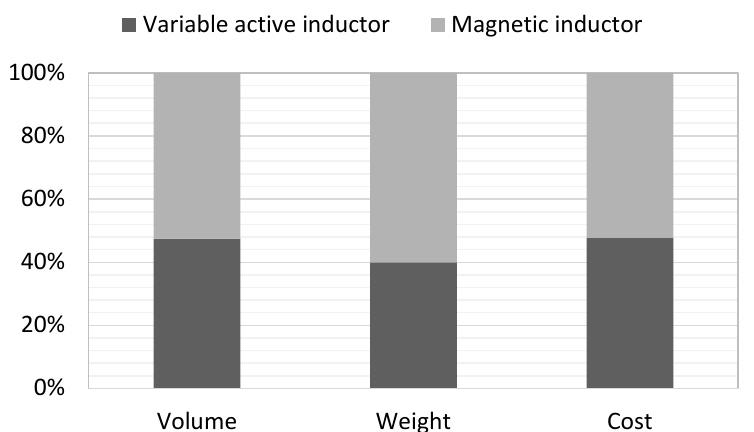
Figure 8. Physical characteristics comparisons between variable active inductor and magnetic in- ductor. Dark grey: variable active inductor; Grey: Magnetic inductor.